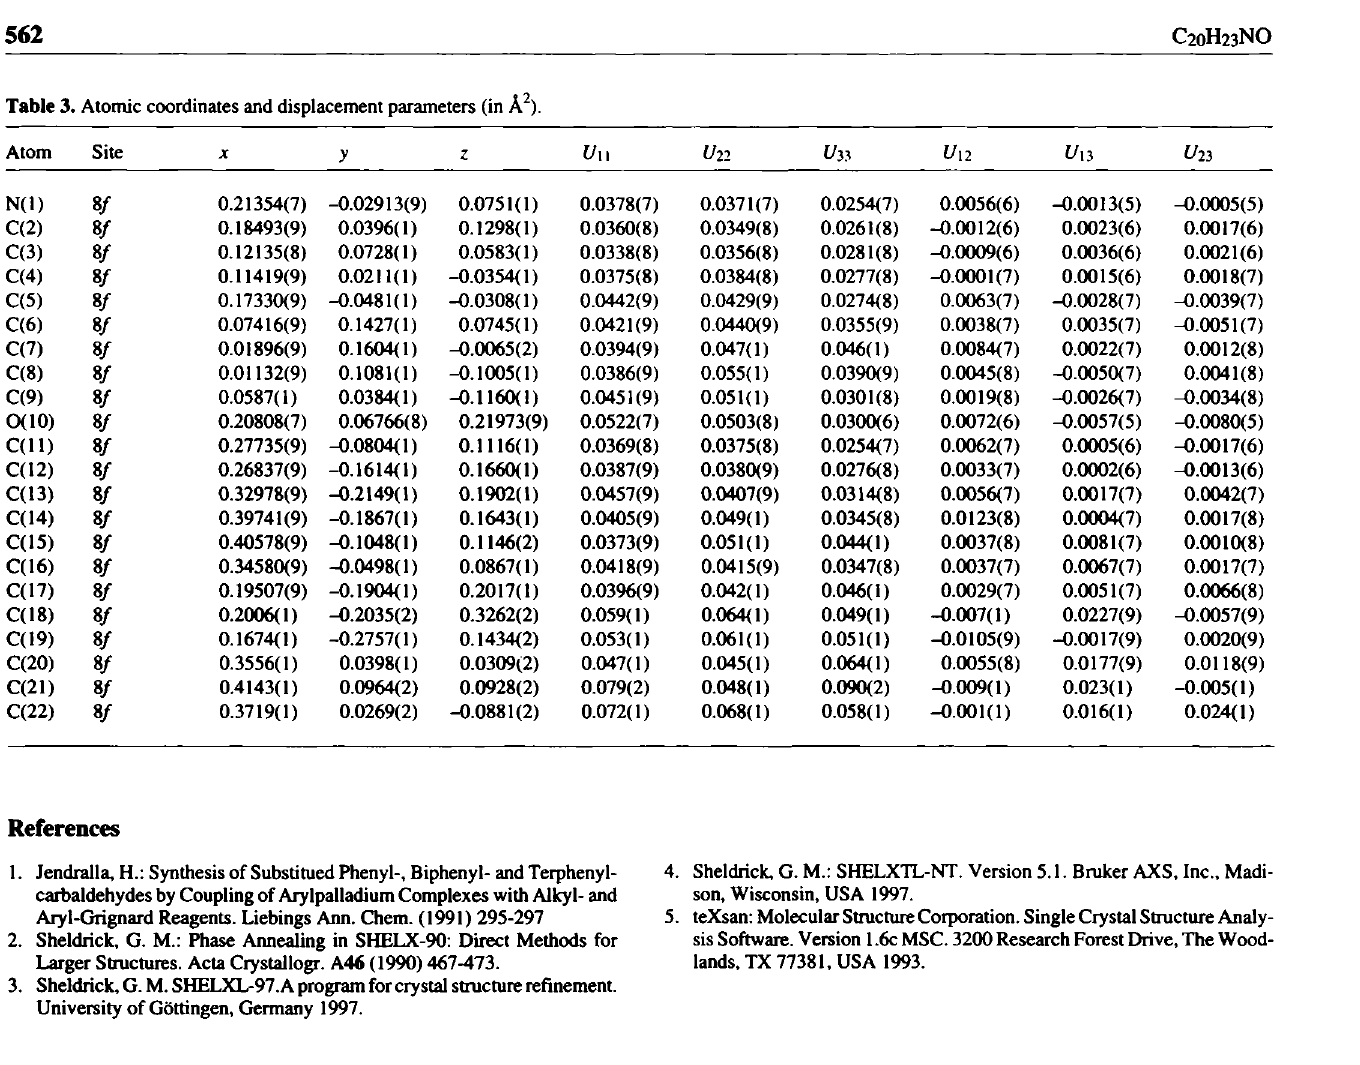
Table 3. Atomic coordinates and displacement parameters (in Â 2